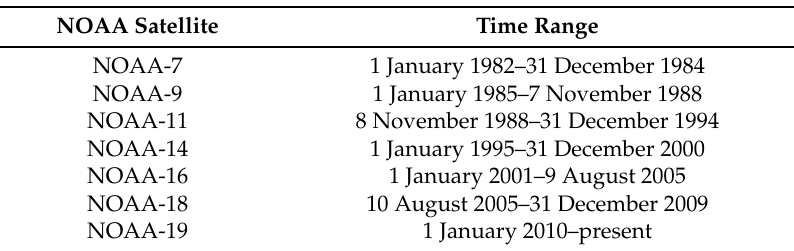
Table 2. NOAA POES satellites used in APP.